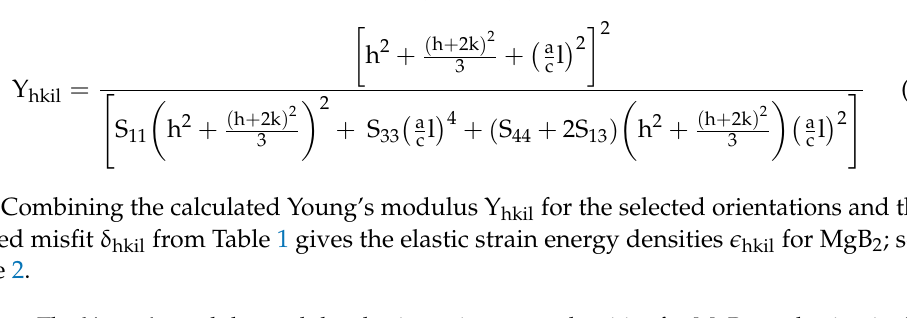
Table 2. The Young’s modulus and the elastic strain energy densities for MgB 2 nucleating in the directions 0002, 1010 and 1210 on the respective nucleation centers Mg and TiB 2